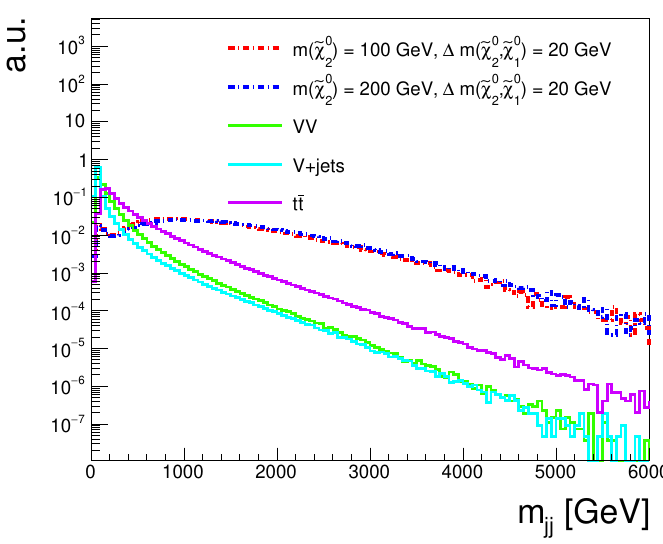
Figure 5 . m jj distribution for jets with p T > 30 GeV and | η | < 5 . 0 , for two benchmark signal points and major